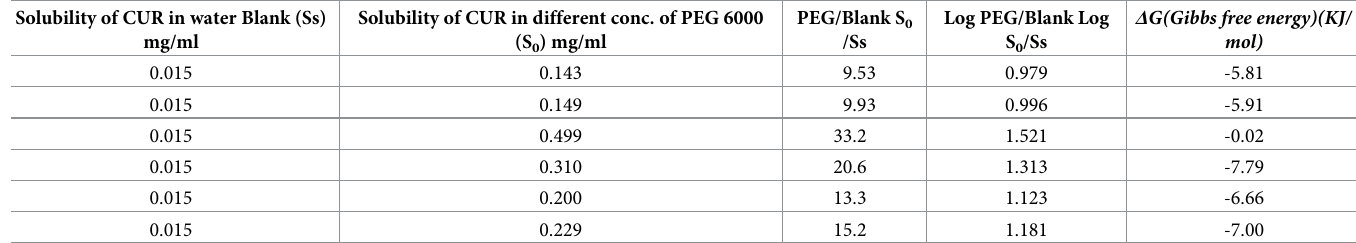
like PEG can improve the solubility and stability of curcumin. Colour of pure curcumin changes from yellow to brownish yellow after making complex with PEG provided a clear indi- cation of physical interaction between CUR and PEG. The solubility of pure curcumin in PBS (pH 7.4) at 37˚C was very low 0.432 μ g/ml whereas solidly dispersed PEG-CUR complex pre- pared by fusion method has 25.3 μ g/ml solubility which was 98% more as compared to pure curcumin. The increase in solubility might be attributed to formation of soluble physical com- plex of curcumin and PEG as PEG 6000 had a capability of increasing curcumin solubility. Central composite rotatable design provides the rotatable 3D plots. These plots help to visu- alize response surfaces for preparation of ointment formulations (Fig 3). Optimum value was reached via the numerical optimization function. Total twelve formulations were prepared as shown in Table 2. Based on the results of solubility, permeation, and anti-bacterial effect four ointment formulations naming CUR-3, PEG-CUR3, CUR-C6, PEG-CUR-C6 were selected for further evaluation. Content uniformity of all optimized formulations were found to be within the range of 95– 110% which showed that CUR and PEG-CUR was uniformly distributed in ointments as Table 1. Calculation of Gibbs free energy of curcumin. Solubility of CUR in water Blank (Ss) Solubility of CUR in different conc. of PEG 6000 mg/ml